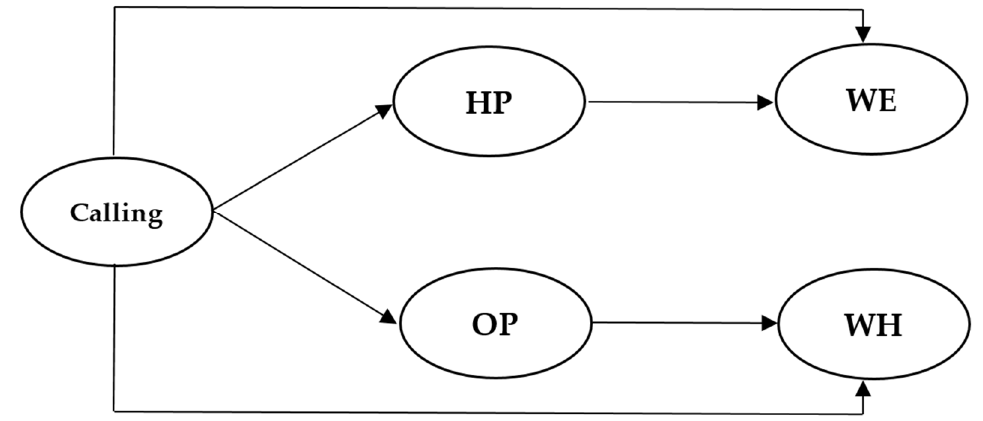
Figure 1. Hypothesized model. HP = harmonious passion; OP = obsessive passion; WE = work engagement; WH = workaholism.